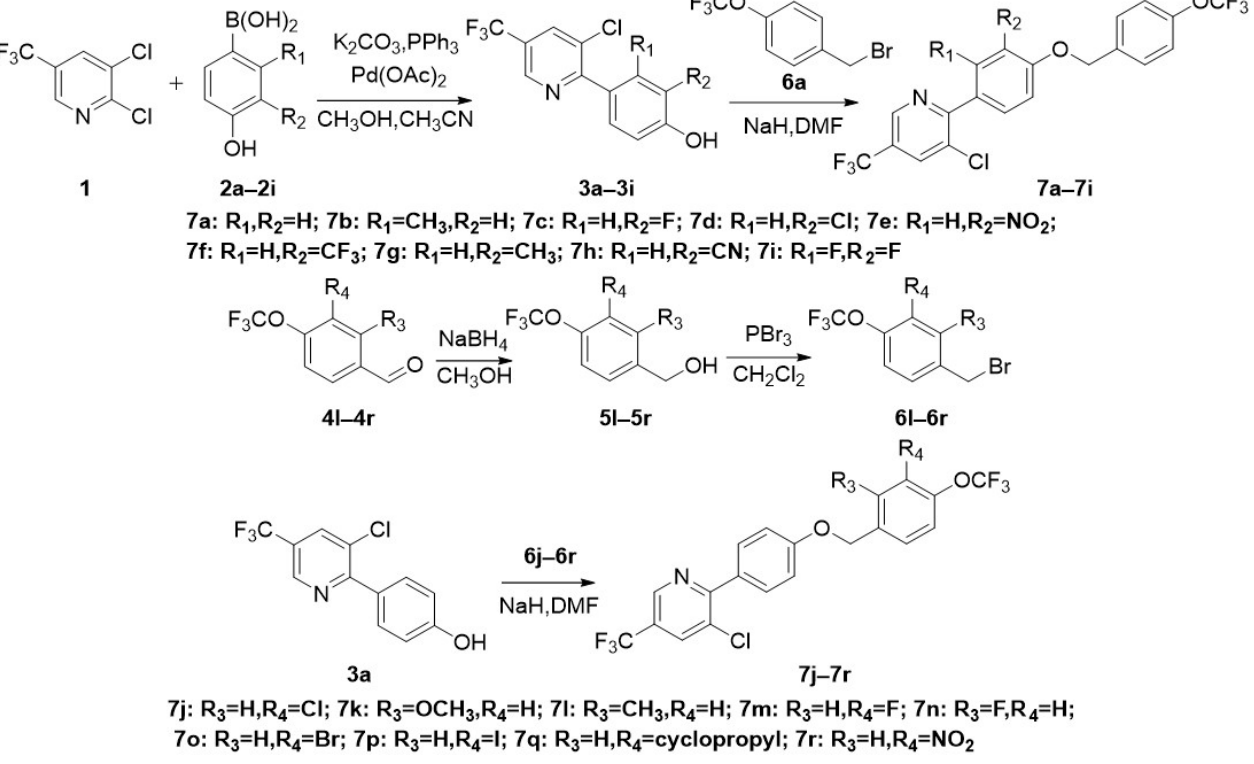
Figure 3. The X-ray crystal structure of compound 7a .